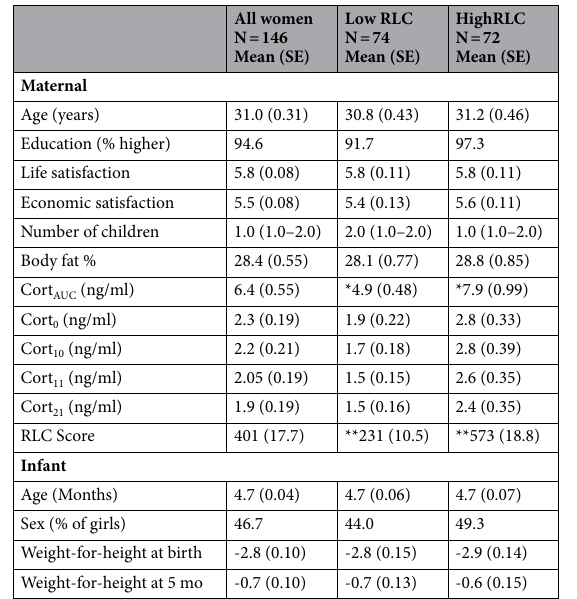
Table 1. General characteristics of 147 mothers and infants participating in the study and differences between lower and higher RLC (Recent Life Changes) score groups. *p < 0.05. **p < 0.01.